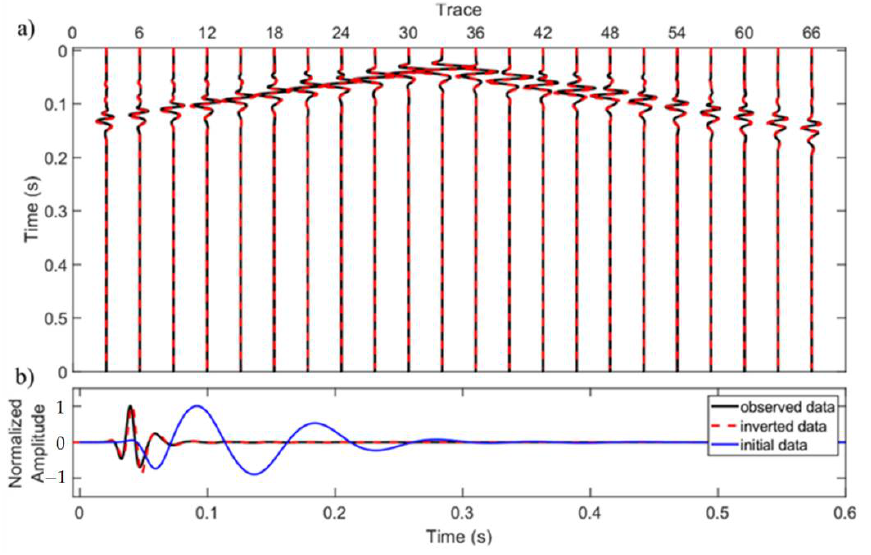
Figure 10. Fitting of the data in the shot at x = 9 m when using a high-frequency source signal. ( a ) Comparison of the vertical velocity observed and inverted seismograms. ( b ) Comparison of the normalized seismograms calculated for the initial, inverted, and observed data for trace 36.